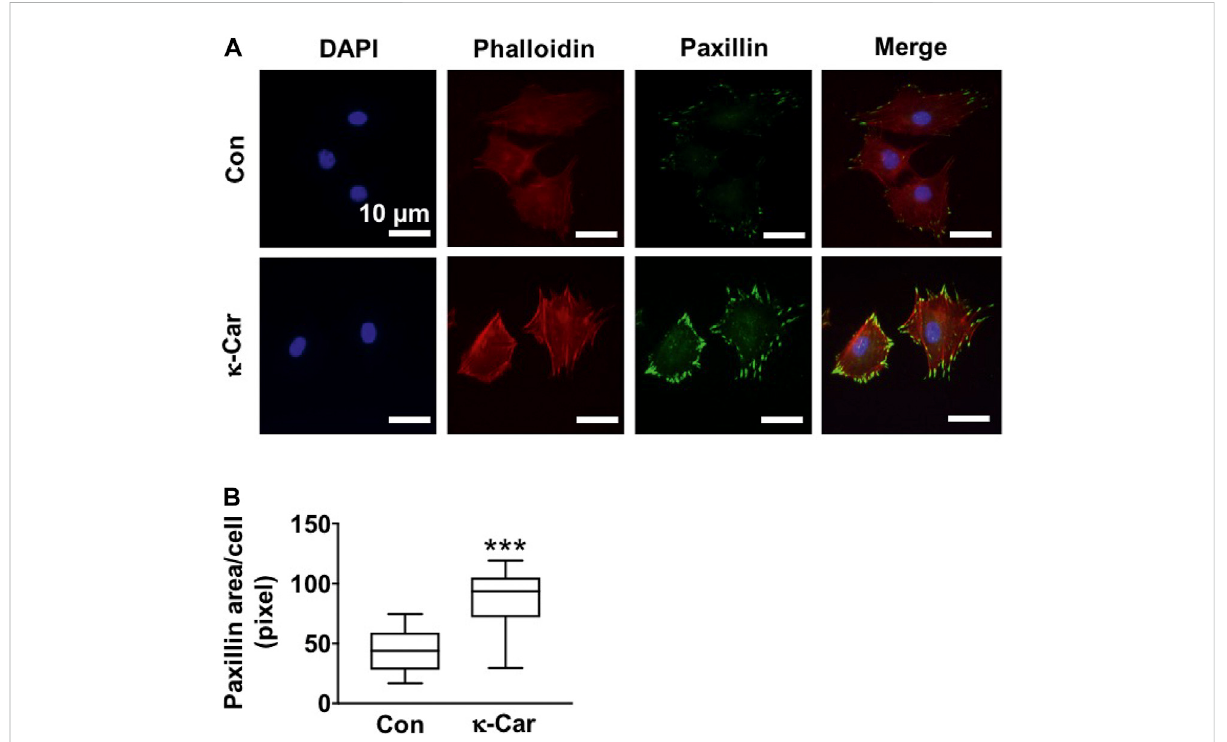
FIGURE 5 Effect of 2 mg/ml κ -carrageenan in OCP-coating of titanium discs on paxillin expression and distribution of MC3T3-E1 pre-osteoblasts at 1 h. (A) Cells stained for DAPI/phalloidin (blue/red) and paxillin (green). (B) Quanti fi cation of paxillin area in untreated control and κ -carrageenan-treated cells. Values are mean ± SD. n = 9 from 3 independent experiments. Signi fi cant effect of κ -carrageenan, *** p < 0.001. Con, control; κ -Car, κ - carrageenan. Bar: 10 μ